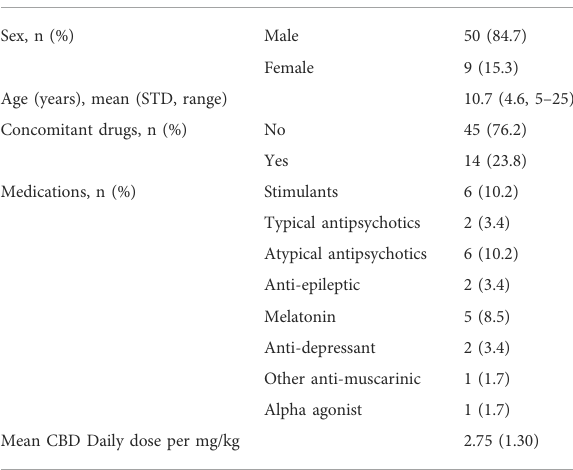
TABLE 1 Patients characteristics and baseline